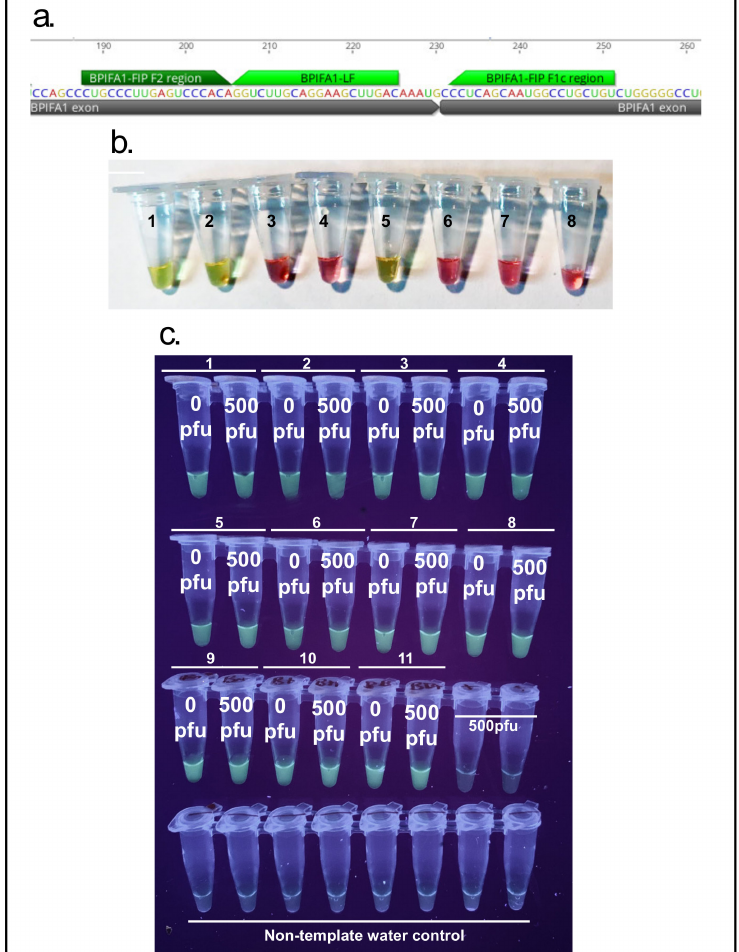
Figure 7. ( a ) BPIFA1 Primers were designed to traverse exon-exon junctions to be mRNA specific; ( b ) BPIFA1 RT-LAMP primer set specificity using New England Biolabs Colorimetric RT-LAMP kit: 1. Nasopharyngeal swab, TRIzol/chloroform extraction 2. Nasopharyngeal swab, Qiagen Viral RNA Mini kit extraction 3. Saliva RNA 4. Blood RNA 5. Nasopharynx flush-through (NFT), Qiagen Viral RNA Mini Kit extraction 6. Human (male) gDNA 7,8. Non-template water control, ( c )—BPIFA1 detection across 11 individuals spiked and non-spiked with SARS-Cov-2, 500 PFU of SARS-CoV-2 and non-template water